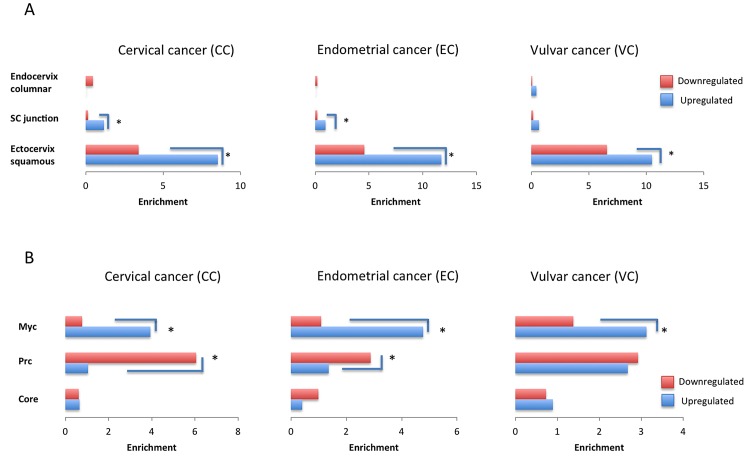
Endocervix columnar, squamocolumnar and ectocervix squamous gene signatures and ES enrichment in cervical, endometrial and vulvar cancer patients.A. Enrichment of differentially expressed genes from our gene signatures of cervical, endometrial and vulvar cancer with endocervix columnar, squamocolumnar junction (SC) and ectocervix squamous gene signatures. For significant differences with p < 0.05, the asterisk was used for annotation. B. Enrichment of differentially expressed genes from our gene signatures from cervical, endometrial and vulvar cancer with Myc, Prc and Core modules, identified to play a key role in the formation and establishment of pluripotency in embryonic stem cells [33]. For significant differences with p < 0.05, the asterisk was used for annotation.